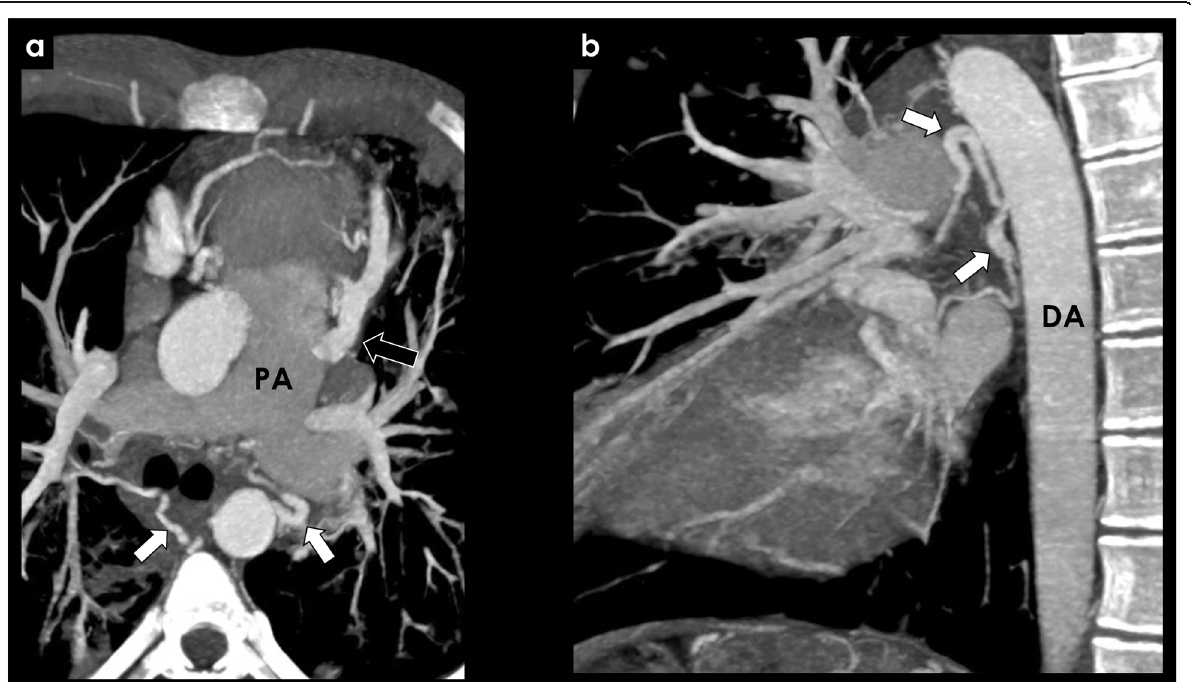
Fig. 5 Congenital causes of BAH — ALCAPA syndrome. Patient with an ALCAPA syndrome. CECT showing an anomalous left coronary artery arising from the pulmonary artery ( a , black arrow) with associated bronchial artery dilatation (white arrows). PA, pulmonary artery; DA, descending